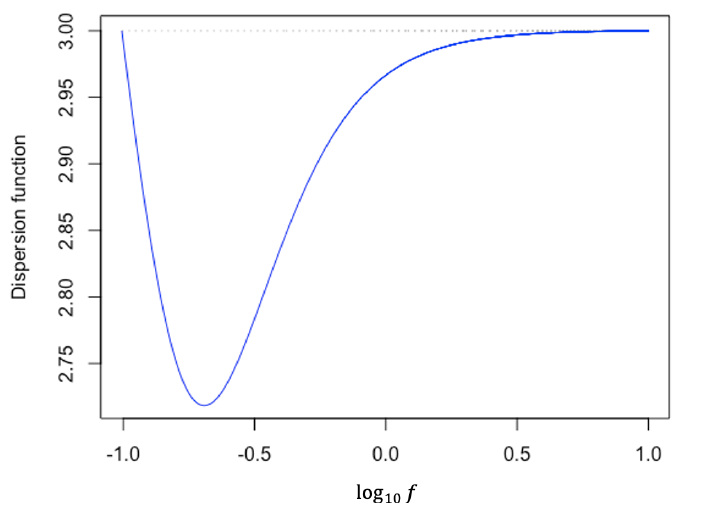
Figure 5. Dispersion function for the D-optimal design for the EEC shown in Figure 1A. The abscissa axis represents the logarithm of the frequency f ( f = ω /2 π